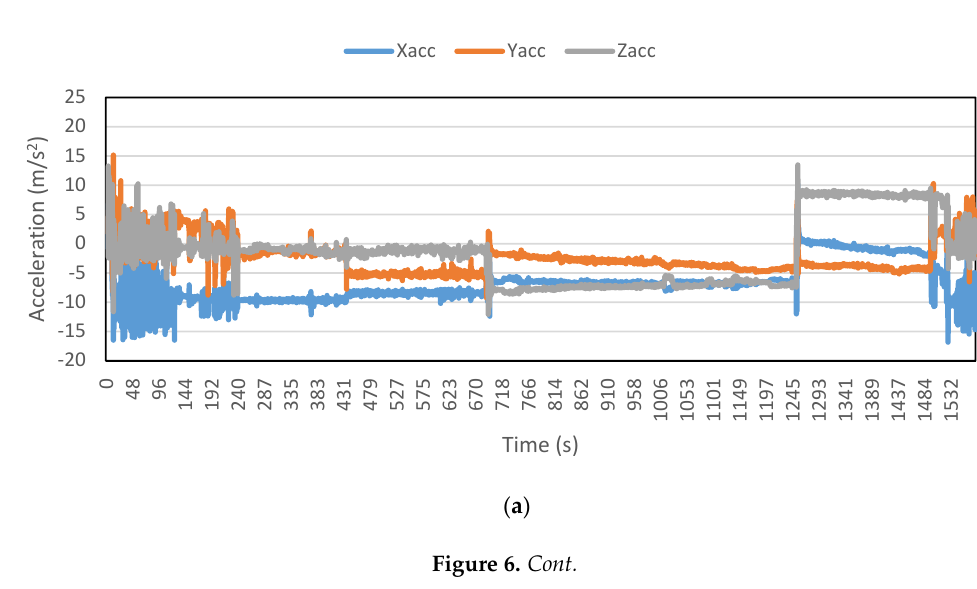
Figure 5. Accelerations recorded for a bus trip: ( a ) Accelerations along three axes; and ( b ) Resultant acceleration.